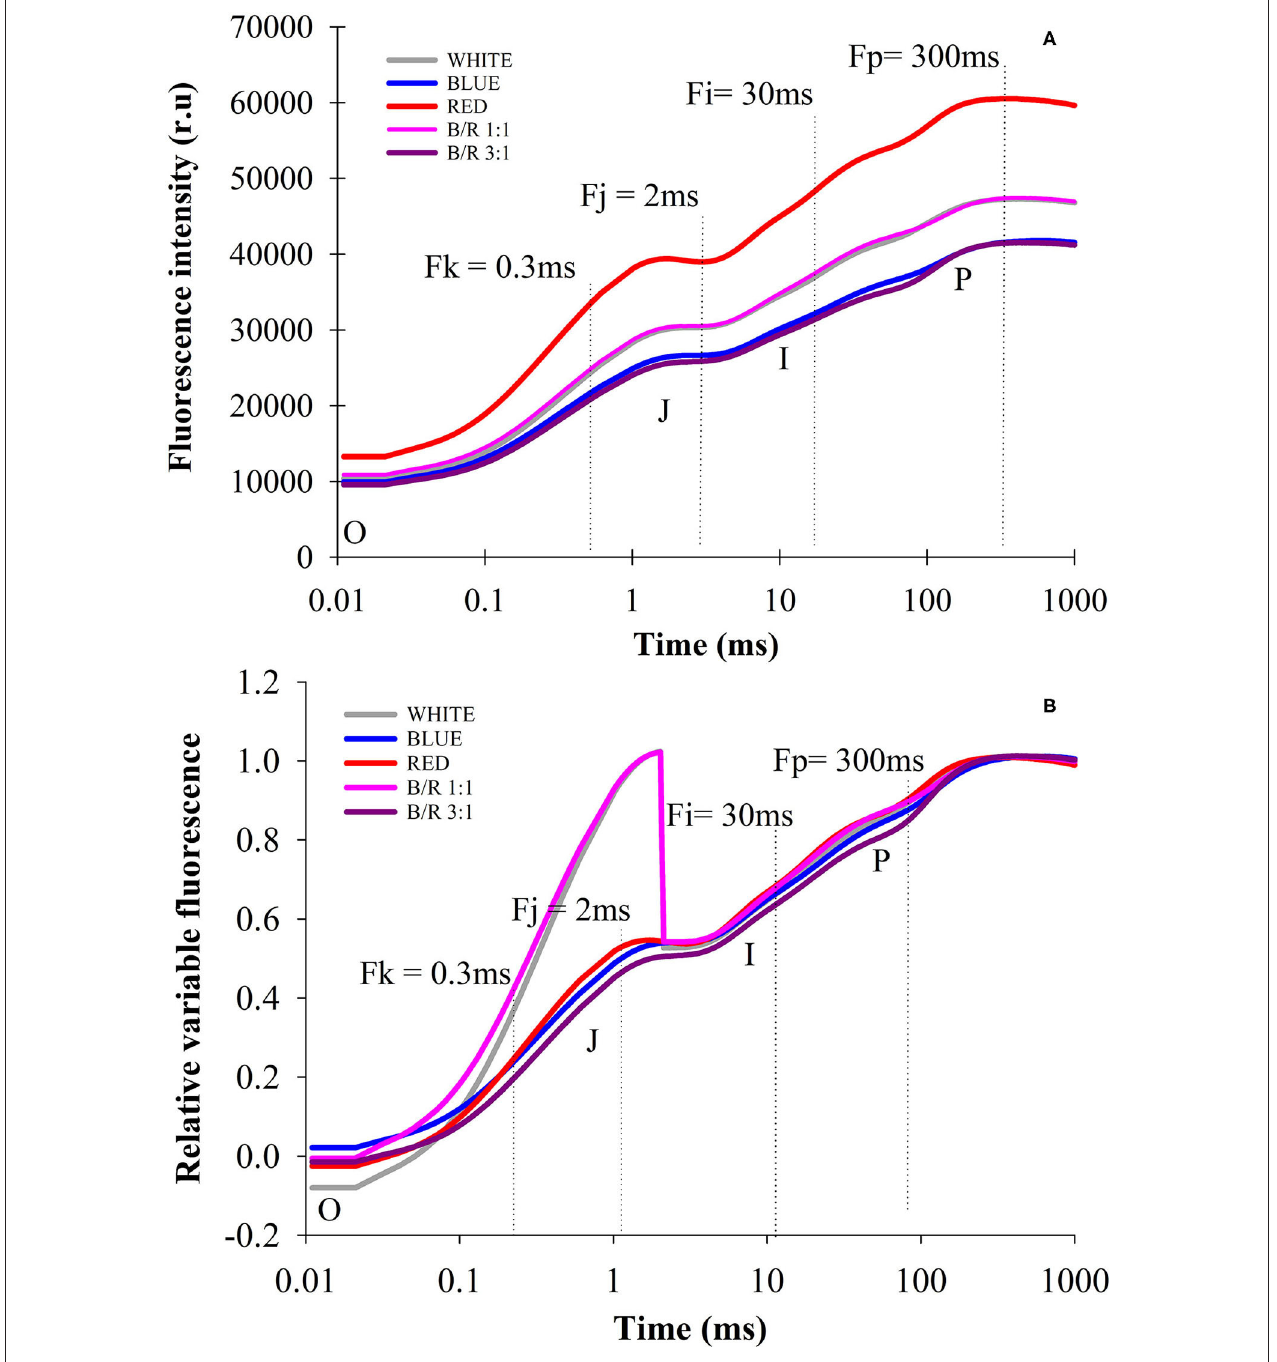
FIGURE 3 | Transients of chlorophyll a fluorescence (OJIP curve), fluorescence intensity (A) and relative variable fluorescence (B) of Brosimum gaudichaudii seedlings at 50 days of in vitro cultivation as a function light spectra of white, blue, red, B/R 1: 1 and B/R 3:1.